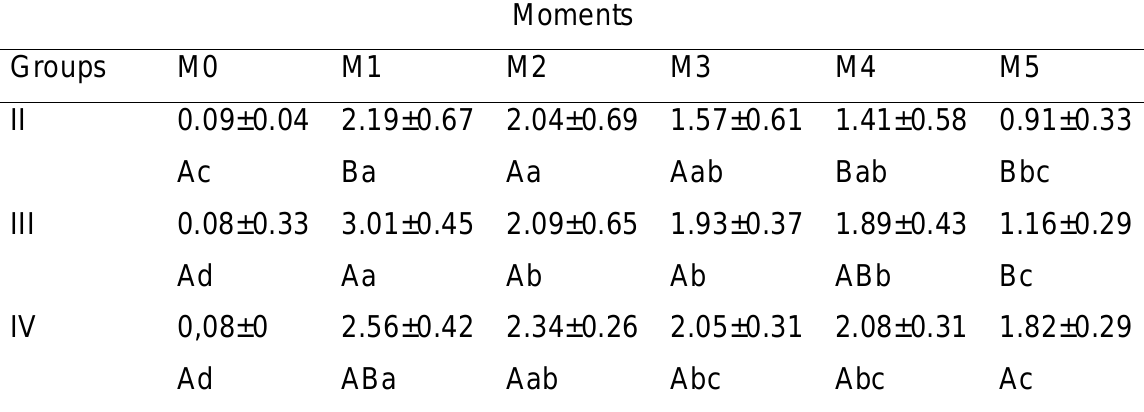
Table 3. Average values of antivenom IgG (µg/ml), obtained by ELISA, in dogs at control and different moments after venom